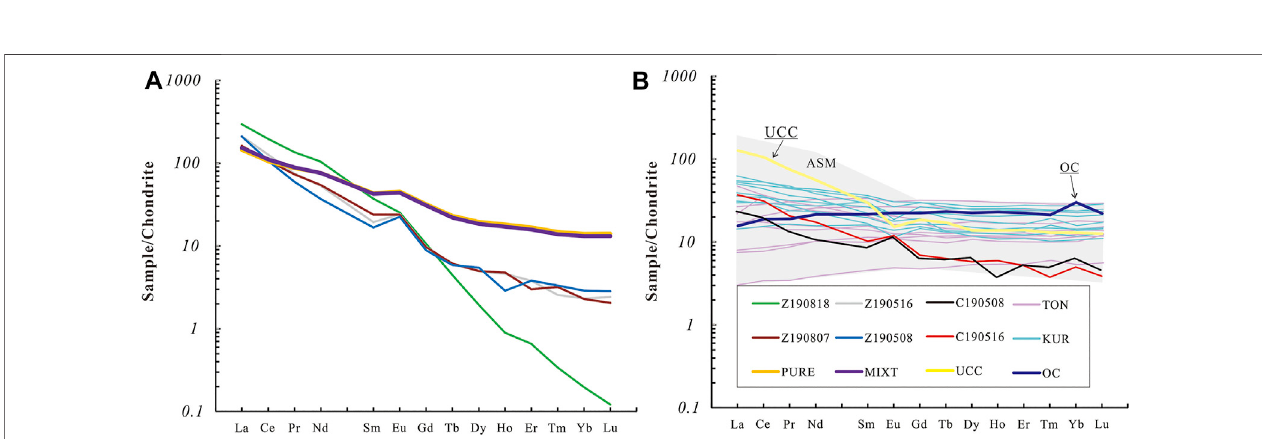
FIGURE5| Chondrite-normalizedrareearthelement(REE)abundancepatternsofthepartialmelts (A) andcalculatedresultscomparedwith fi eldobservations (B) . C1-Chondrite data are from Sun and Mcdonough (1989). Z190818, Z190516, Z190708, and Z190508, partial melts from our experiment; PURE and MIXT, our starting materials.C190508andC190516,calculatedresultsbasedonourexperimentdata,thepartitioncoef fi cient( D i )betweenmeltsandstartingmaterialfromourexperiment in runs at 950 ° C could be got [ D i = (i in Melt)/(i in Starting material)], then we used this partition coef fi cient to calculate the i content in melts from pure OC (OC = oceaniccrust)(C190508)and10%UCC(UCC=UpperContinentalCrust)+90%OC(C190516),weusethismethodcomparingtheREEabundancefrompartialmelting experiment and silicic arc magma located at Tonga Island and Kuril Island.; TON = typical REE abundance patterns from silicic magma located at Tonga Island, KUR = typicalREEabundancepatternsfromsilicicmagmalocatedatKurilIsland.ASM=arcsilicicmagma,REEabundancepatternsfromTONandKUR.DataofTONandKUR are also from the GEOROC website (http://georoc.mpch-mainz.gwdg.de/georoc/).